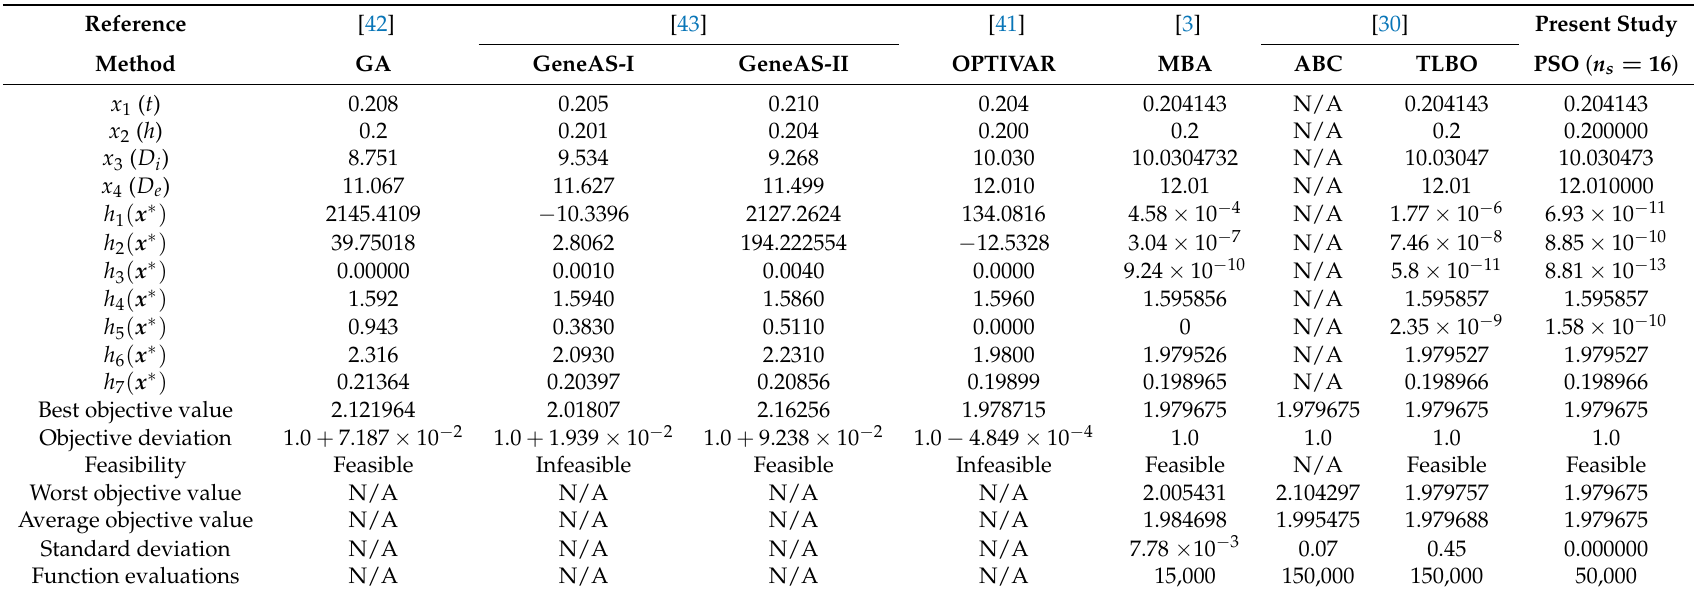
Table 8. Optimization results of the Belleville spring design